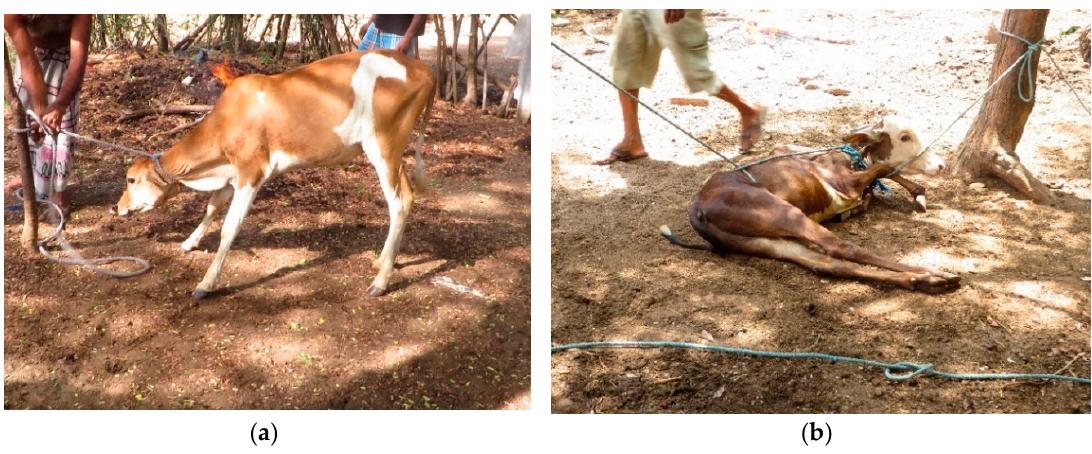
Figure 1. In preparation for branding, animals were roped around the neck ( a ) and laid on the ground ( b ).